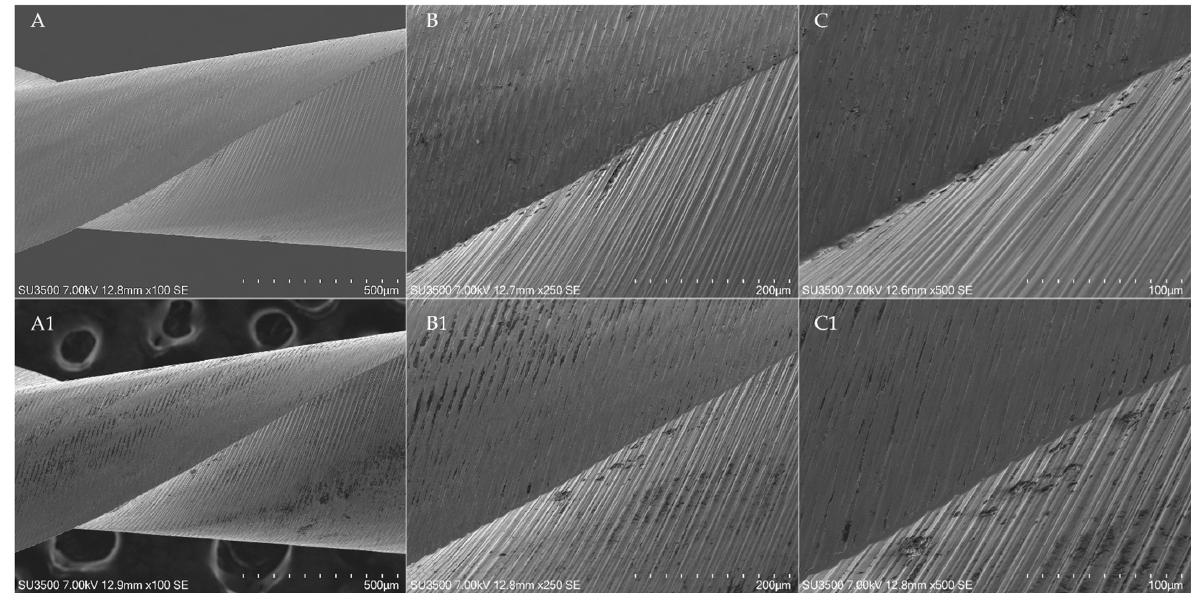
Figure 9. SEM images representing the imperceptible flattening of cutting edges of R25 Blue instrument after 4 simulated clinical uses at three different magnifications (from left to right respectively, of ×100, ×250 and ×500). ( A – C ) cutting edge of R25 Blue new instrument. ( A1 – C1 ) the